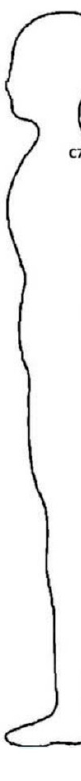
Figure 3. The trunk inclination angle (TIA). Abbreviations C7—seventh cervical vertebra, S1—first sacral vertebra.